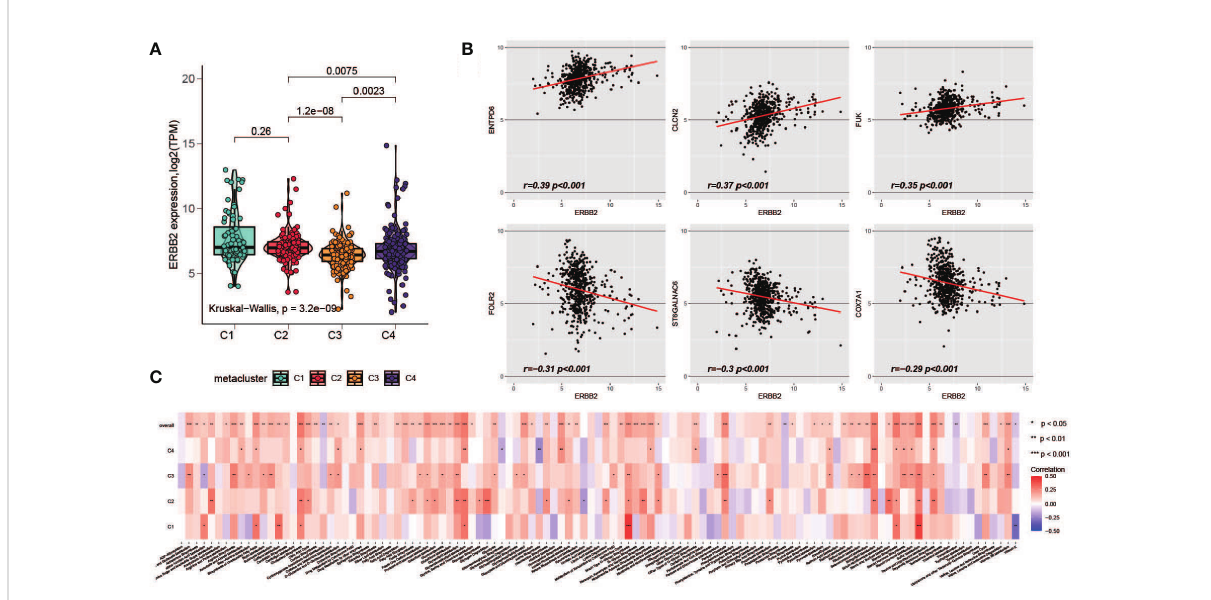
FIGURE 7 Association of HER2 and metabolism-related genes. (A) Comparison of HER2 expression level among C1-C4. (B) Top positively and negatively HER2-correlated metabolism-related prognostic genes (C) The correlation of HER2 with metabolism pathways in each